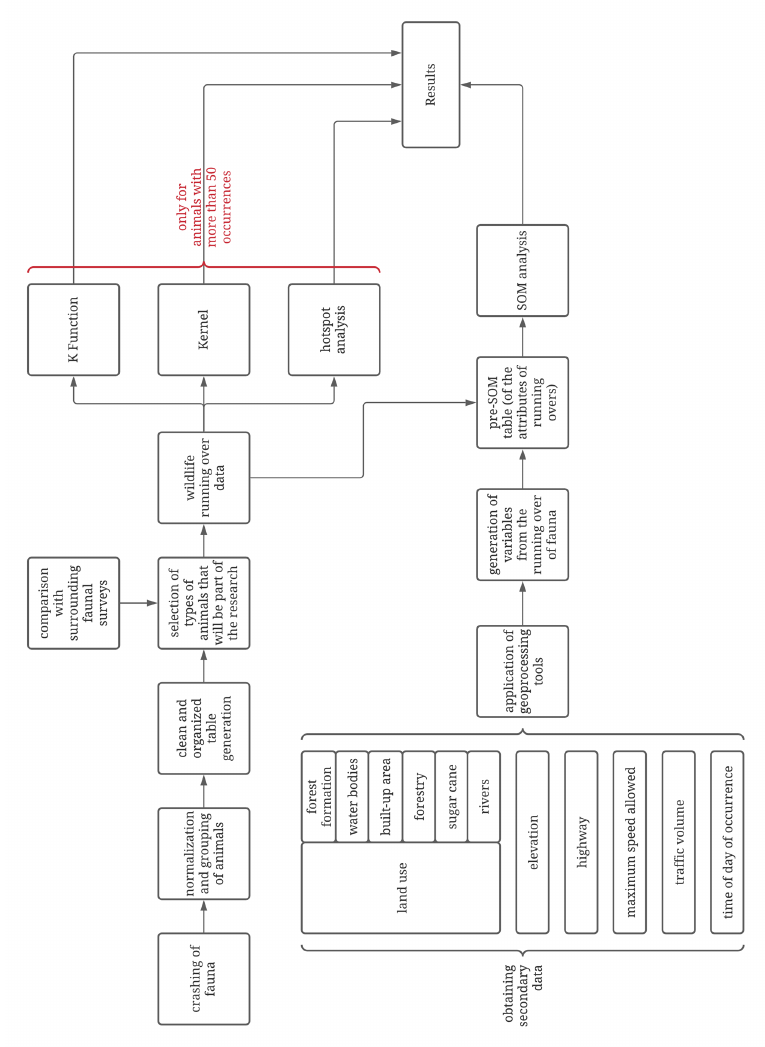
Figure 3. Flowchart of the exploratory SOM